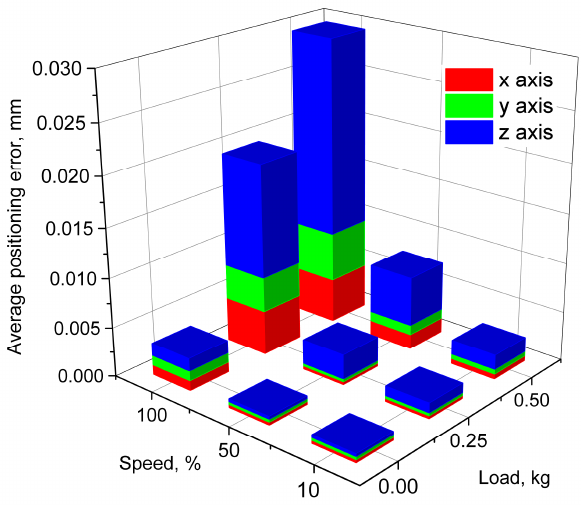
Figure 9. Positioning errors of the robot when it operates at various speeds and loads.